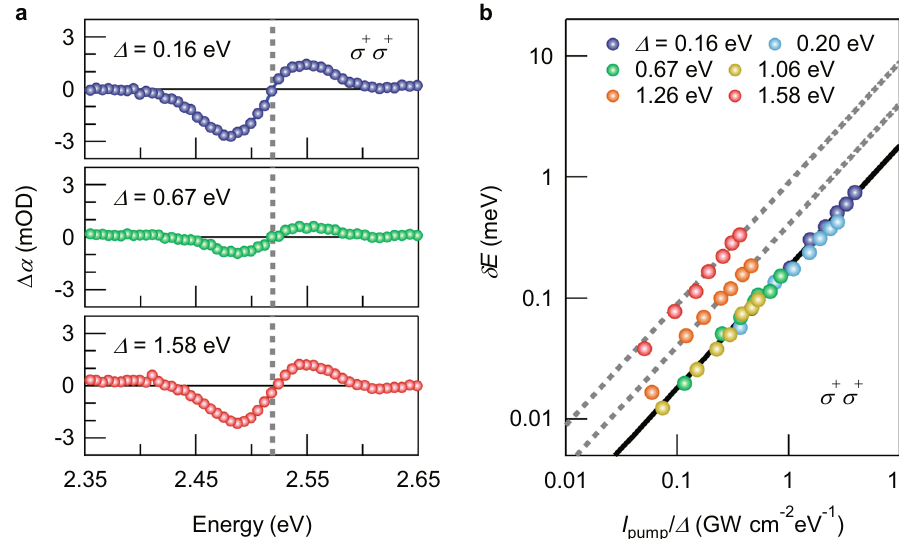
Fig. 2 Δ dependence of the energy shift in the σ + σ + con fi guration. a Δ α spectra at t pp = 0 ps for different detuning energies. The pump intensity was set to 0.56 GW/cm 2 . The gray dashed line indicates the band-edge exciton transition energy derived in Fig. 1b. b Log – log plot of the energy shift as a function of I pump / Δ for different detuning energies Δ . The black line shows the δ E Stark calculated using Eq. (1) for μ = 19 D. The gray dashed lines serve as guides to the